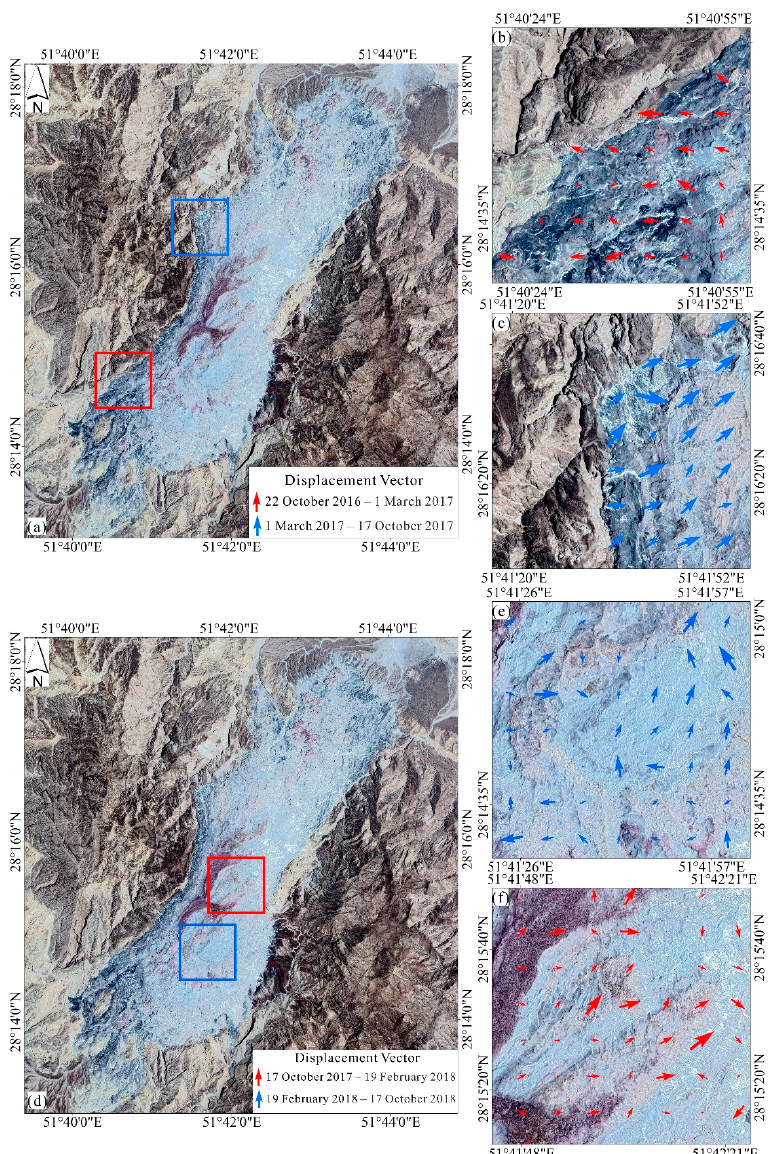
Figure 6. Vector field derived from four Sentinel-2A/B image pairs from 22 October 2016 to 17 October 2018. The red arrows represent the displacement vector during the rainy season, and the blue arrows represent the displacement vector during the dry season. The pointing of the arrow represents the direction in which rock salt flows. ( a ) The location of selected two zones of the flank; ( b ) the vector field of the red rectangle zone of the flank during the rainy season; ( c ) the vector field of the blue rectangle zone of the flank during the dry season. ( d ) The location of selected two zones of the dome; ( e ) the vector field of the blue rectangle zone of the dome during the dry season; ( f ) the vector field of the red rectangle zone of the dome during the rainy season.